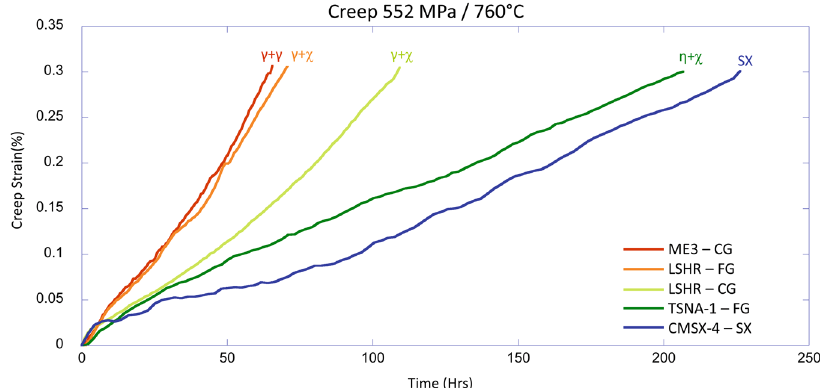
Fig. 2 Creep curves. Creep curves for coarse-grain ME3, coarse grain LSHR, fi ne grain HIP TSNA-1, and CMSX-4 at 760 °C and 552 MPa. TSNA-1 exhibited a signi fi cant improvement in creep resistance over ME3 and LSHR superalloys despite having a much fi ner microstructure.